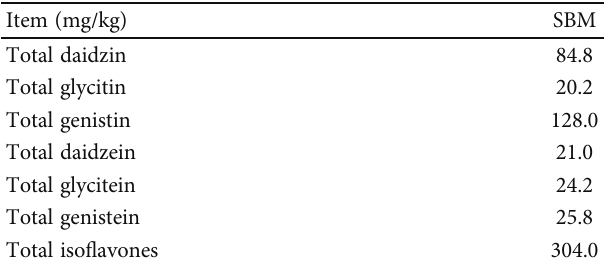
Table 3: Analyzed soy iso fl avone concentrations of the SBM diet (% dry